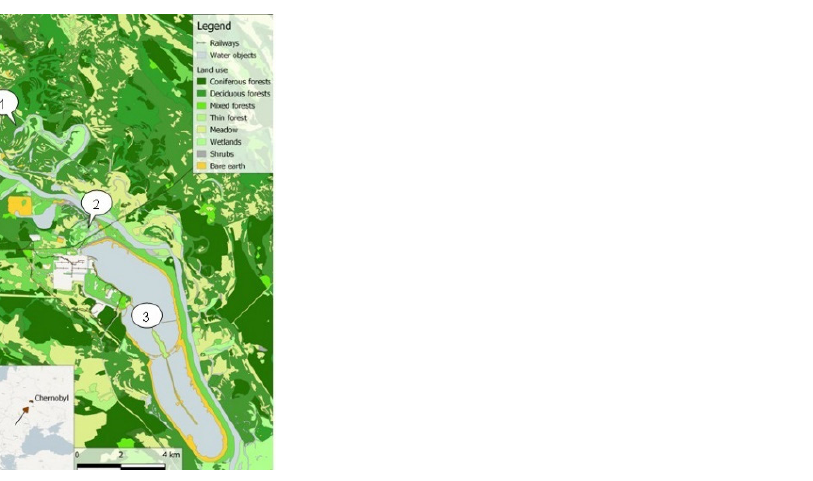
Figure 1. Location of the studied water bodies in the Chernobyl exclusion zone on the map of land use: 1—Lake Glubokoe; 2—Lake Azbuchin; 3—Chernobyl NPP cooling pond. Table 1. Characteristics of the studied water bodies in the Chernobyl exclusion zone. Water body